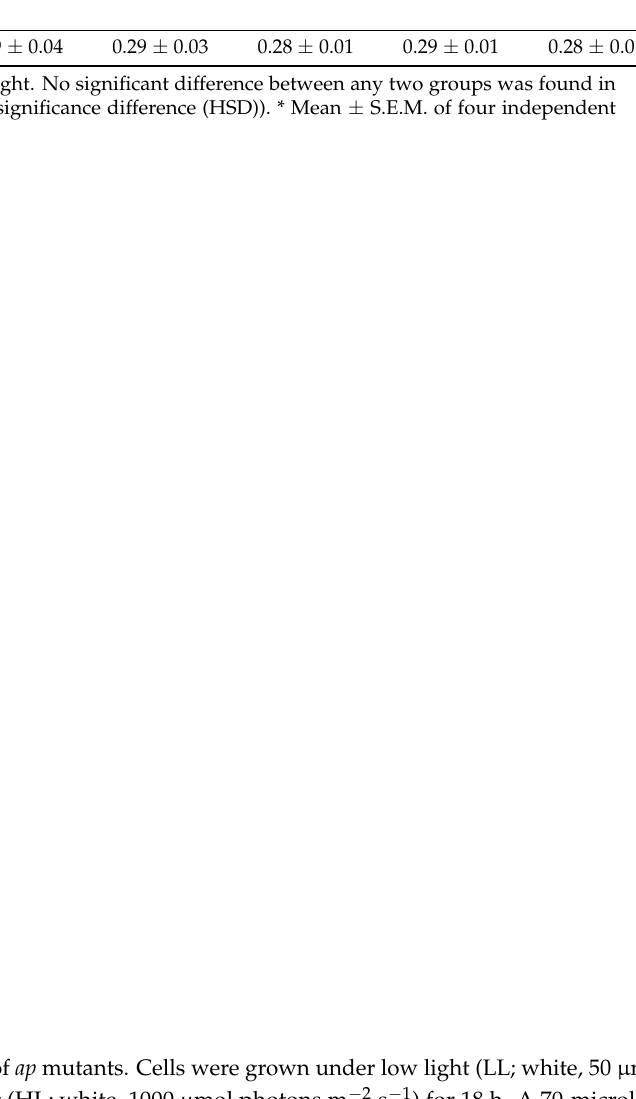
Figure 3. High-light tolerance of ap mutants. Cells were grown under low light (LL; white, 50 μ mol photons m − 2 s − 1 ) or high light (HL; white, 1000 μ mol photons m − 2 s − 1 ) for 18 hr. A 70-microliter aliquot was put in a well of a 96-well plate.